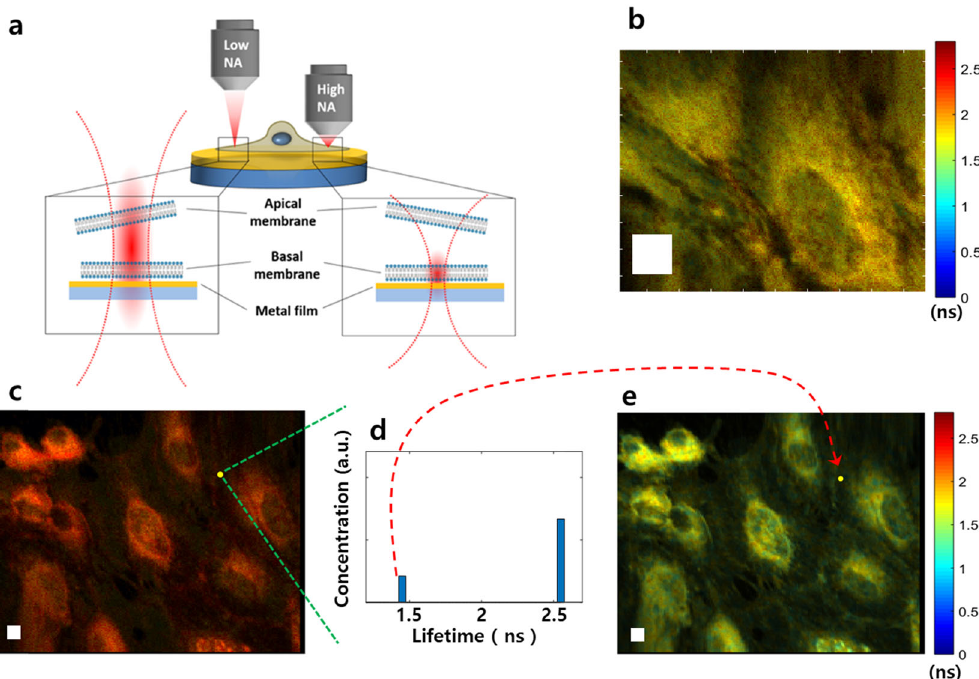
Fig. 1 Large-FOV FLIM with biexponential signal analysis. a Geometry of apical/basal membranes of a cell, a metal fi lm coated substrate, and the axial intensity pro fi les of excitation laser beams with high-NA and low-NA objectives. A high-NA objective is used in conventional MIET imaging to excite or collect signals from the basal membrane. b Small-FOV FLIM image measured with a high-NA objective (NA = 1.49, ×60) for human aortic endothelial cells (HAECs) stained with CellMask ™ Green. HAECs are grown on a cover glass with a thin Au fi lm on it. The image consists of 254 × 196 pixels, and its FOV is 40 μ m × 32 μ m. c Large-FOV FLIM image of the same HAEC sample measured with a low-NA objective (NA = 1.0, ×20). It has 254 by 196 pixels and covers a large-FOV of 120 μ m × 96 μ m. d Extracted lifetime components, and their concentrations for a speci fi c pixel in ( c ). A fast deconvolution algorithm based on a library of exponentials ( “ Method ” ) is used. The longer lifetime is for the apical membrane of a cell, and the shorter one is for the basal membrane. e Reconstructed FLIM image from ( c ) by using the shorter lifetime of each pixel. White boxes are squares of 5 μ m side